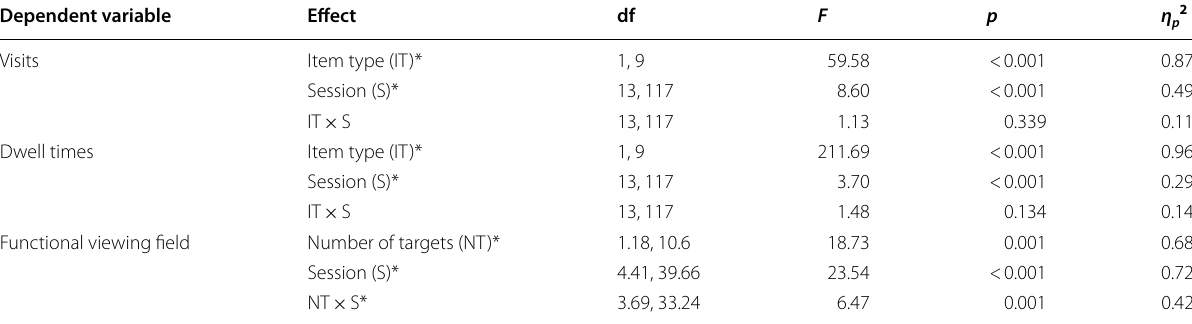
Table 4 Results of analyses on raw value eye-tracking measures